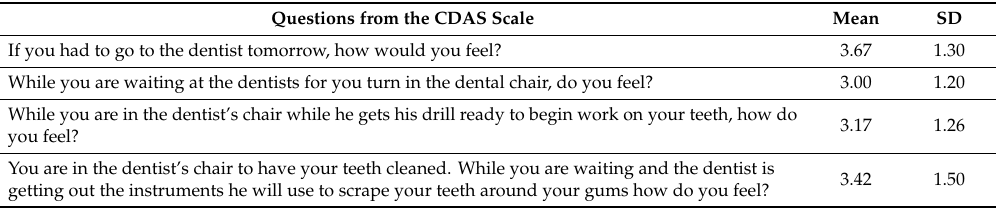
Table 1. Means and standard deviations of the Corah Dental Anxiety Scale (CDAS) [26] scale. Questions from the CDAS Scale Mean SD